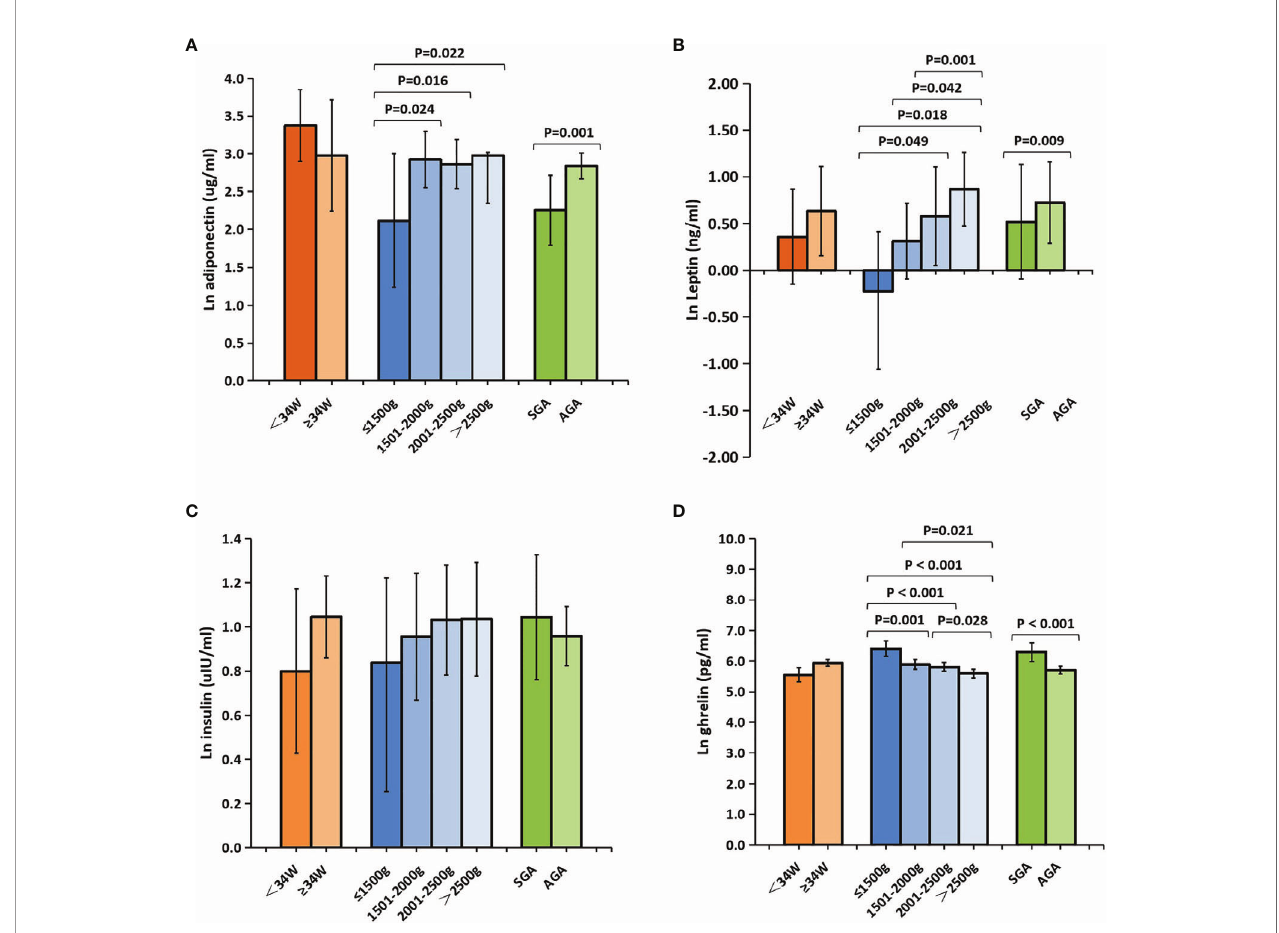
FIGURE 2 | Comparison of the cord plasma concentrations of adiponectin (A) , leptin (B) , insulin (C) , and ghrelin (D) among the subgroups of preterm newborns after natural logarithmic (ln) transformation. Data were analyzed after adjusting for sex, mother ’ s age, delivery mode, weight gain during pregnancy, and pre- pregnancy BMI between the different GA groups, and for sex, mother ’ s age, delivery mode, GA, weight gain during pregnancy, and pre-pregnancy BMI among the different BW groups and the SGA/AGA groups. All data are expressed as 95% CIs. Values in bold are signi fi cant at p < 0.05. BMI , body mass index; SGA , small for gestational age; AGA , appropriate for gestational age; GA , gestational age; BW , birth